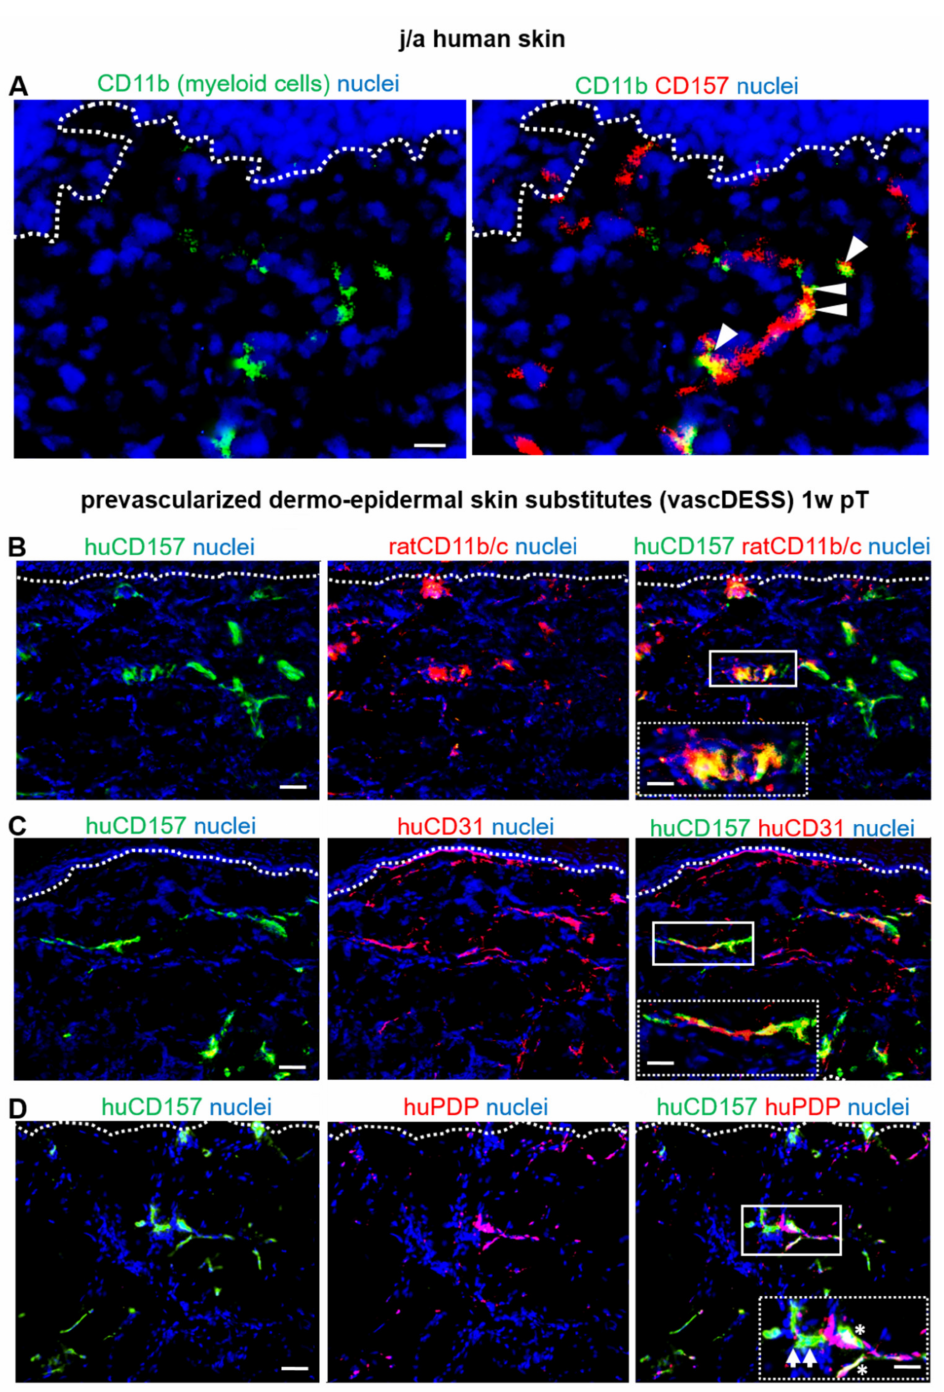
Figure 6. CD157 expression pattern on prevascularized dermo-epidermal skin substitutes (vascDESS) in vivo ( A ) Human myeloid CD11b-expressing cells in j/a foreskin sections co-localized with CD157 + capillaries (white arrowheads). ( B ) Multiple rat CD11b/c myeloid cells infiltrated vascDESS with the vast majority of them binding to CD157 + capillaries in dermal part in vivo after 1 week post- transplantation (pT). Insets represent magnified images of respective framed areas. ( C , D ) Immunoflu- orescence staining of in vivo transplants 1 week (w) post-transplantation (pT) confirm huCD157 expression on all human CD31 capillaries (n = 3 independent donors ( C ), including podoplanin- negative (PDP − , white arrows) blood and podoplanin-positive (PDP + , white asterisks) lymphatic capillaries (n = 5). Scale bars: 50 µ m (images) and 100 µ m (inserts). Dotted lines delineate dermo- epidermal